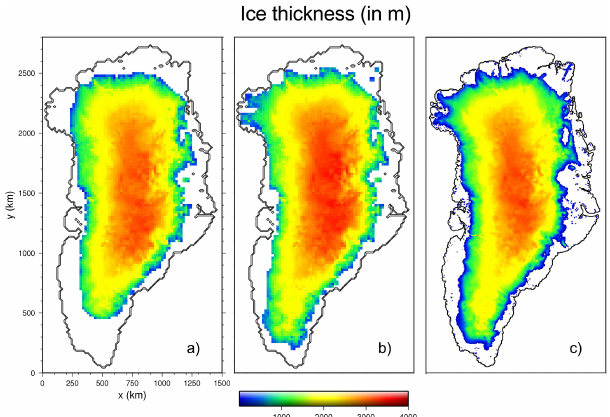
Figure 1. Ice thickness of the Greenland Ice Sheet before ( a , Exp. 1a, see Table 2) and after ( b , Exp. 1b) the downscaling procedure, after 10000 ice model years. This is compared to measurement data ( c , Bamber et al.,